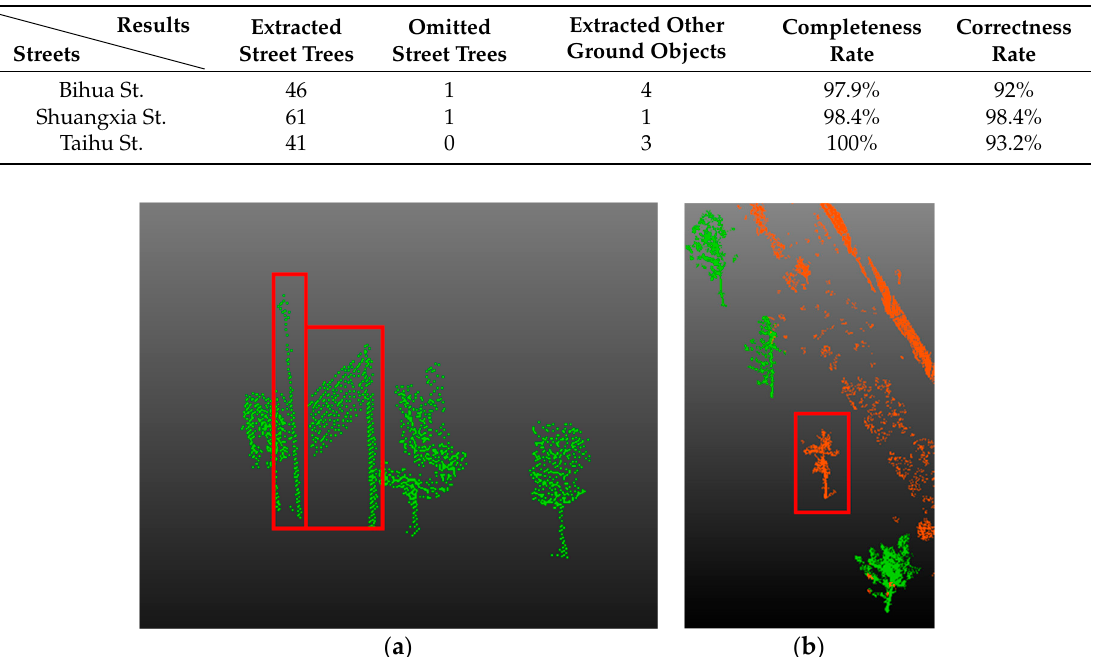
Figure 11. False extraction results generated by the proposed method. ( a ) False positives; ( b ) False negative.